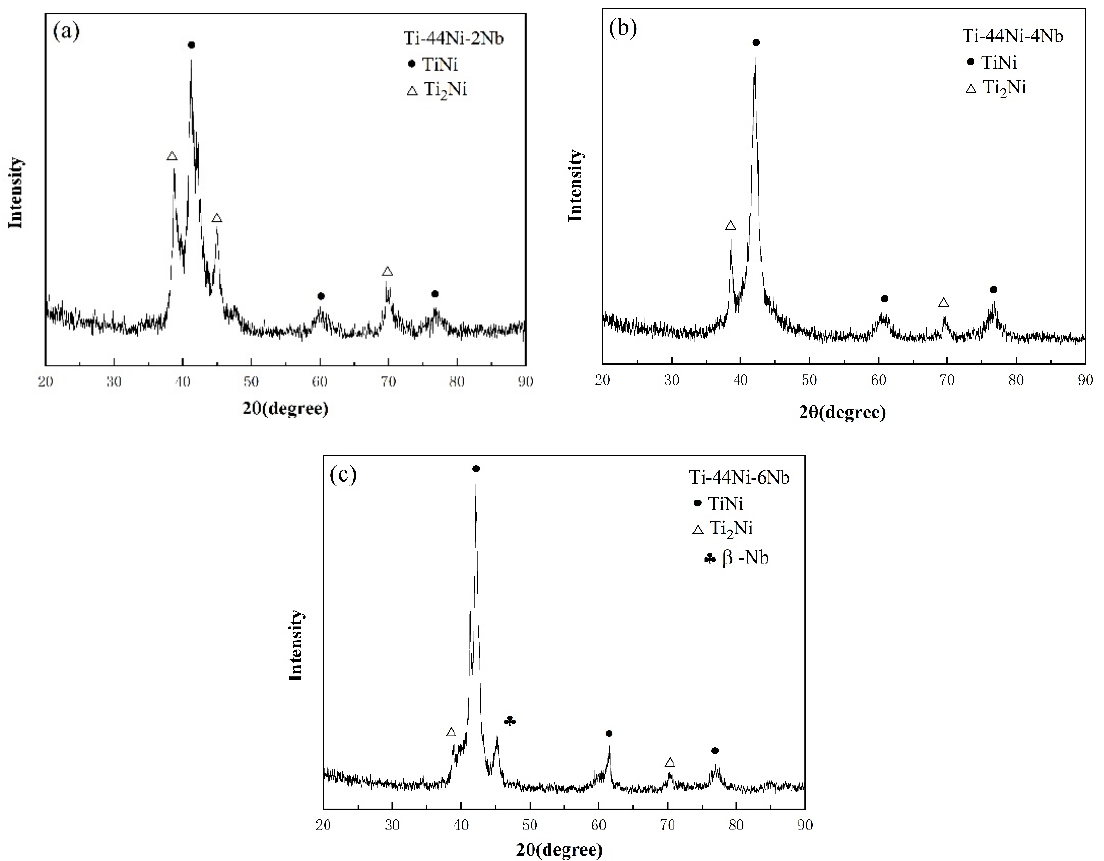
Figure 1. XRD patterns of: ( a ) TiNi 44 Nb 2 , ( b ) TiNi 44 Nb 4 , and ( c ) TiNi 44 Nb 6 alloys.